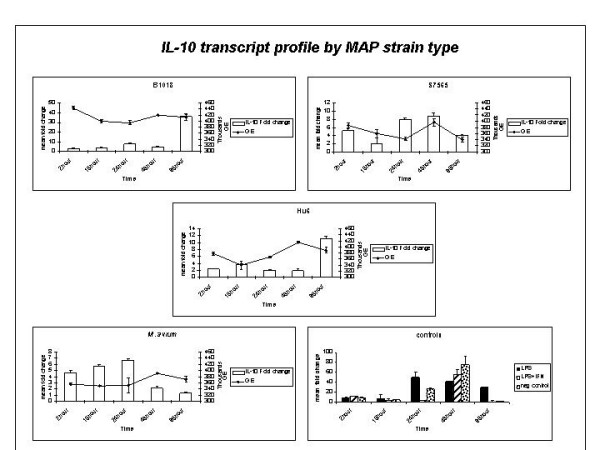
IL-10 mRNA expressed by MDM cells exposed to M. paratuberculosis strains over time was measured by Real time RT PCR and fold change in gene expression relative to β actin was calculated by 2-ΔΔCT method. Mean fold change in gene expression is plotted on Y-axis (note that the Y1-axis scales have been optimized for magnitude of IL-10 expression for each strain). Intracellular bacterial numbers based on the amplification of hsp65 were calculated based on genome size of MAP and represented as genome equivalents (GE) on second Y-axis. MDMs stimulated with B1018 and Hu6 MAP isolates increased IL-10 mRNA by 96 hrs PI relative to cell stimulations by S7565 MAP isolate and M. avium.